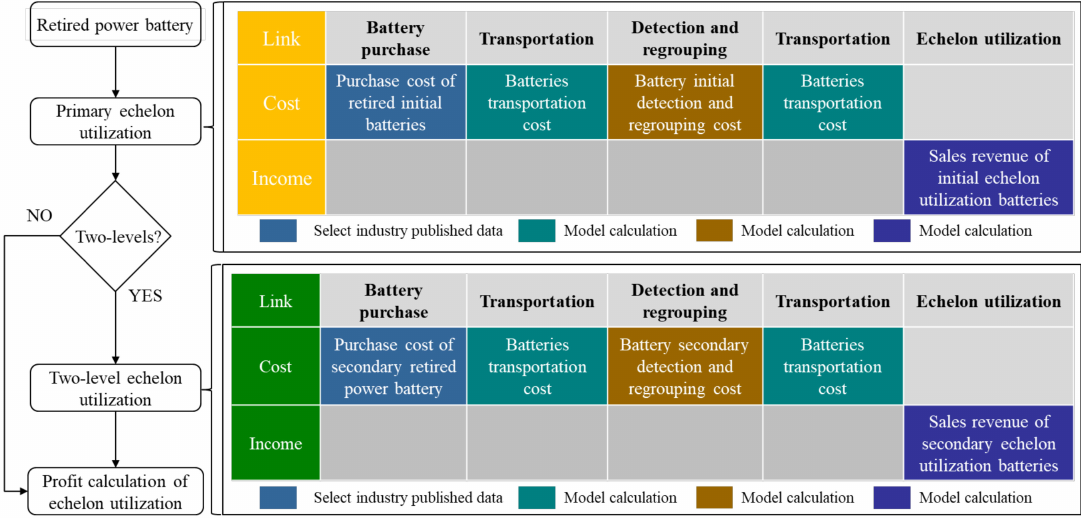
Figure 6. Block diagram of economic benefit evaluation model for the echelon utilization of retired power